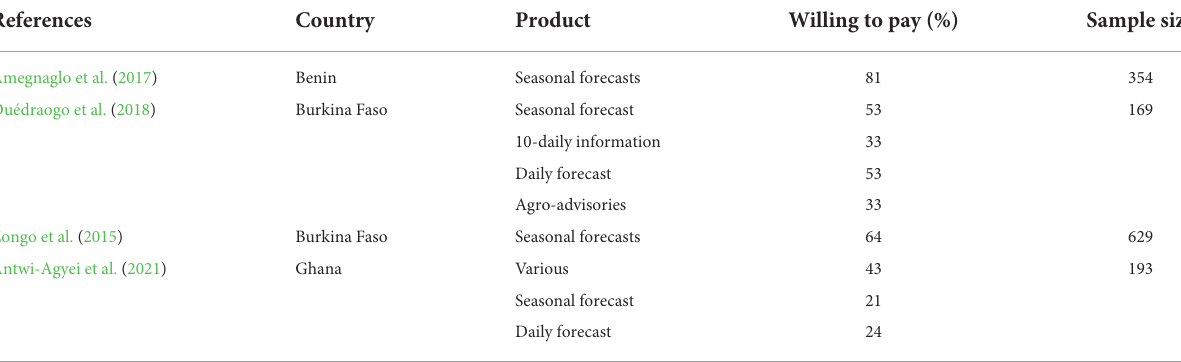
TABLE 5 Published studies of the proportion of farmers willing to pay for weather and climate